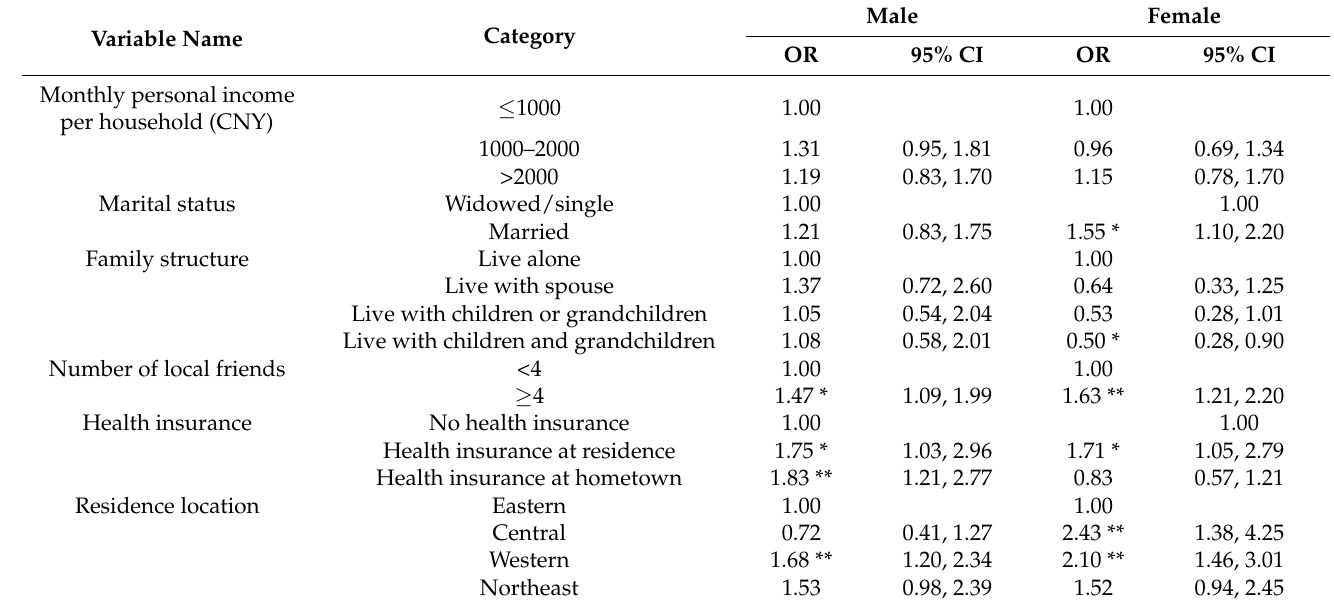
Table 2. Multivariate logistic regression on factors associated with enrolment in free physical